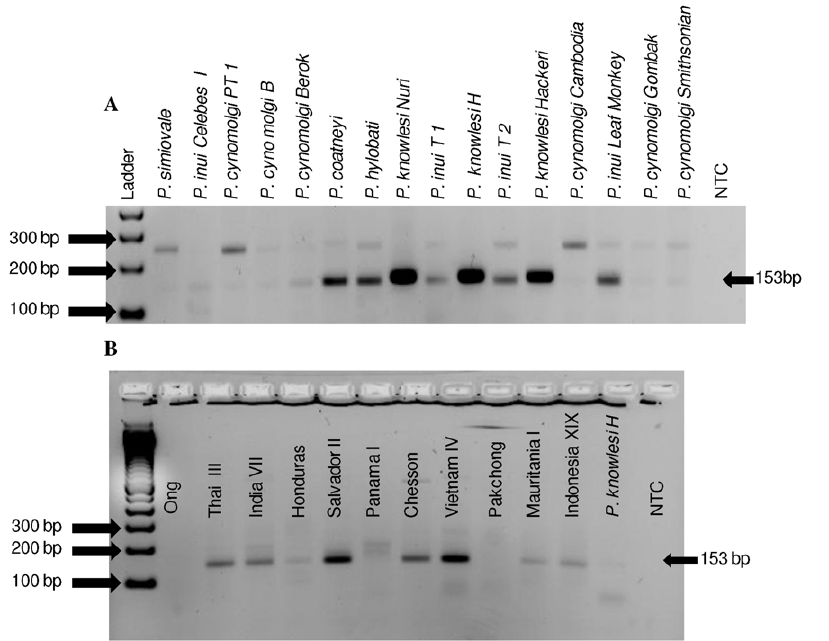
Figure 1. 18S ribosomal RNA gene based P.knowlesi primer cross-reacts with P.vivax and other simian-infecting malaria species. Published 18S ribosomal RNA gene based P. knowlesi primers [3] were used to test 5 different simian-infecting malaria parasite species ( P. simiovale , P. inui , P. cynomolgi , P. hylobati and P. coatneyi ) including 3 different P. knowlesi isolates (A) and 11 P. vivax strains (B). A no template control (NTC) was included. Cross reactivity was observed with some of the simian malaria parasites and some P. vivax strains.